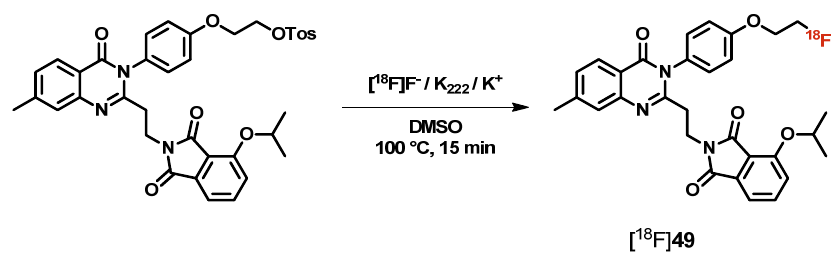
Scheme 14. Radiosynthesis of [ 18 F] 49 . Scheme 14.